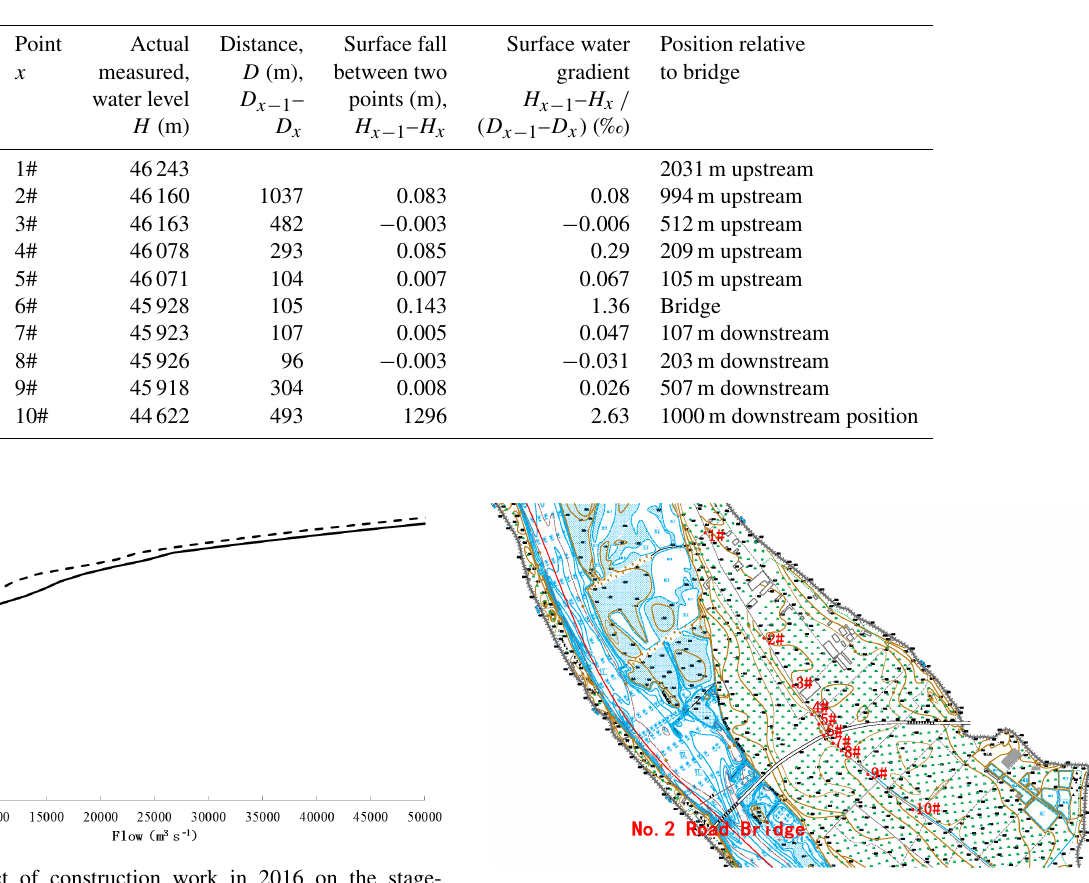
Figure 6. The measuring points at the Road No. 2